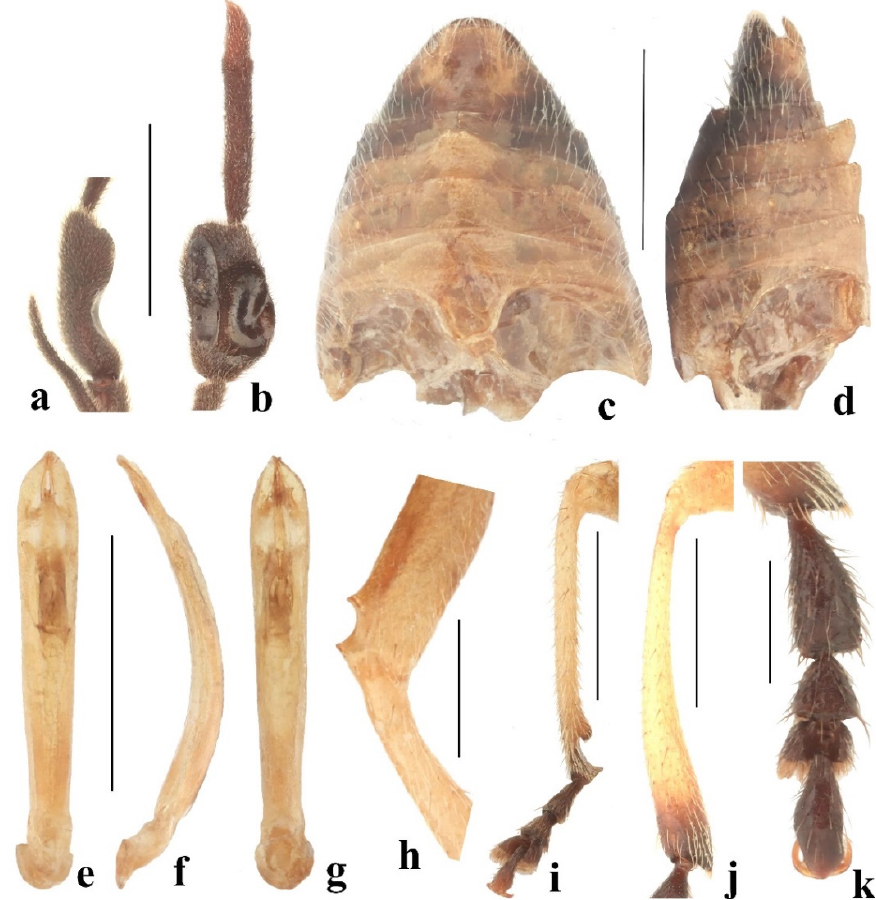
Figure 17. Taumacera sigiriya sp. nov.: ( a ) antennomere X, lateral view; ( b ) antennomeres X–XII, ventral view; ( c ) abdomen, ventral view; ( d ) abdomen, lateral view; ( e ) aedeagus, dorsal view; ( f ) aedeagus, lateral view; ( g ) aedeagus, ventral view; ( h ) mesofemur; ( i ) mesotibia; ( j ) metatibia; ( k ) metatarsus. (Scale bars: ( a – g , i , j ) = 1 mm, ( h , k ) = 0.5 mm). The pronotum (Figure 16c) is transverse, 1.48 times as wide as long, semiopaque, glabrous, covered with microsculpture and sparse fine punctures, and widest at the ante- rior third. The surface has two round impressions in the posterior half. The anterior mar- gin is widely concave, bordered, and with long setae on lateral parts, unbordered in the middle, and without setae. The lateral margins are sinuate with distinct borders, and mar- gins with sparse, long setae. The posterior margin is straight and oblique in lateral parts, nearly straight in the middle part, and narrowly bordered, and a margin which has several erected long setae near posterior angles. The anterior angles are distinctly swollen, poste- rior angles obtusangulate, and all angles with setigerous pores are bearing very long, pale setae. The scutellum is triangular, covered with fine microsculpture and indistinct punc- tures, and glabrous. The elytra are 1.65 times as long as wide (measured at the humeral calli) and 0.65 times as long as the body, subparallel, widest in middle. The surface is densely covered with small, confused punctures; along the suture and lateral margins it is slightly finer, on a disc with tendencies to form indistinct longitudinal rows, and on lateral and apical slopes sparsely covered with erect setae forming longitudinal rows. The subscutellar area of each elytron is slightly convex. The epipleura are smooth, glabrous, wide at the basal half, then gradually narrowed towards the elytral apex. The humeral calli and hind wings are developed. The metasternal process is 1.43 times as long as wide, widest at the base, slightly convergent to the apex, and preapical lateral parts are rounded, and with a long narrow